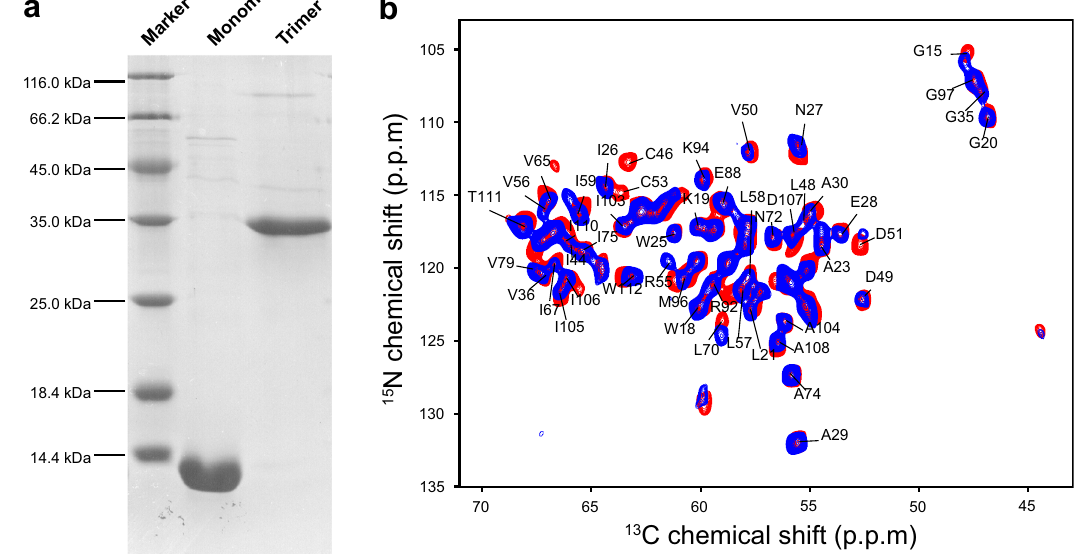
Fig. 2 Unfolding and refolding of DgkA. a Presence of DgkA monomers formed by unfolding in buffer (8 M urea, 0.2% SDS, 1% formic acid, pH 2.9) and DgkA trimers formed by refolding/reassembling in buffer (8 M urea, 0.2% SDS, 0.08% E. coli membrane total extracts, 0.96% OG, pH 7.8) were con fi rmed by SDS-PAGE. b Superposition of the 2D NCA spectrum of no-cys-DgkA undergoing successive unfolding and refolding (blue) with that of wild- type DgkA without unfolding and refolding (red). In no-cys-DgkA, all three cysteine residues (C46, C53, and C113) have been mutated into alanine or isoleucine